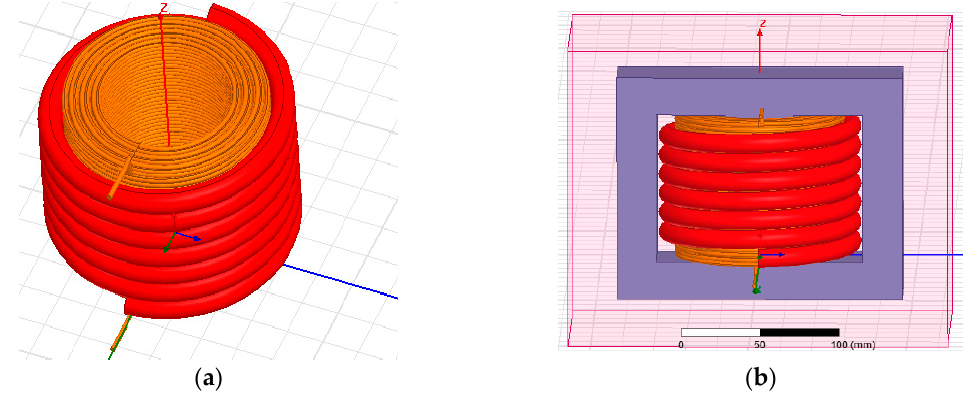
Figure 7. High frequency ferrite core transformer. ( a ) Primary and secondary coil. ( b ) Complete transformer model placed within an air medium. Table 4. Parameters of a high frequency ferrite transformer.